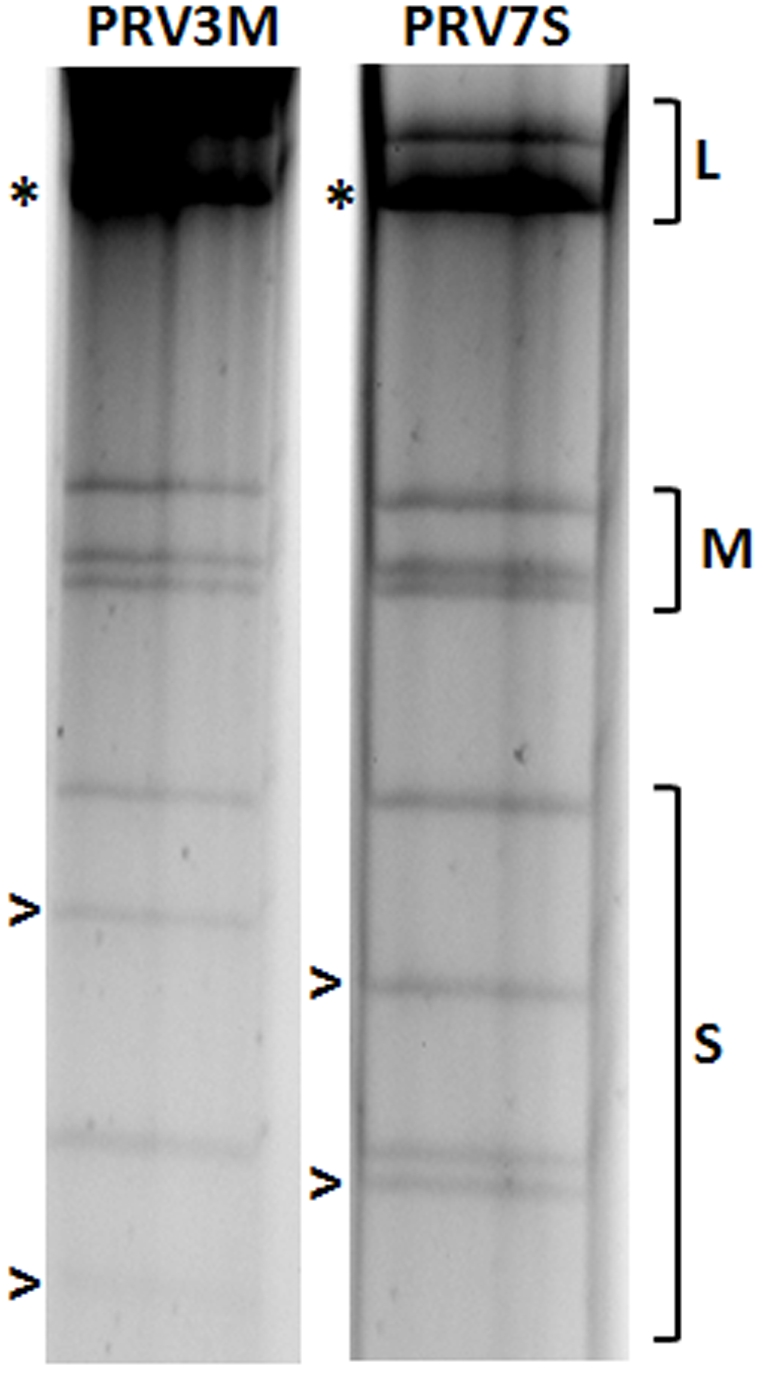
Comparison of genome segment profiles between PRV3M and PRV7S.The genome segments were separated in a 10% SDS-polyarylamide gel. The classes of genome segments (L, M and S) are labeled on the right. The asterisk (*) indicates co-migrating bands and the open arrow (>) indicates cognate segments of the two viruses with a different mobility.